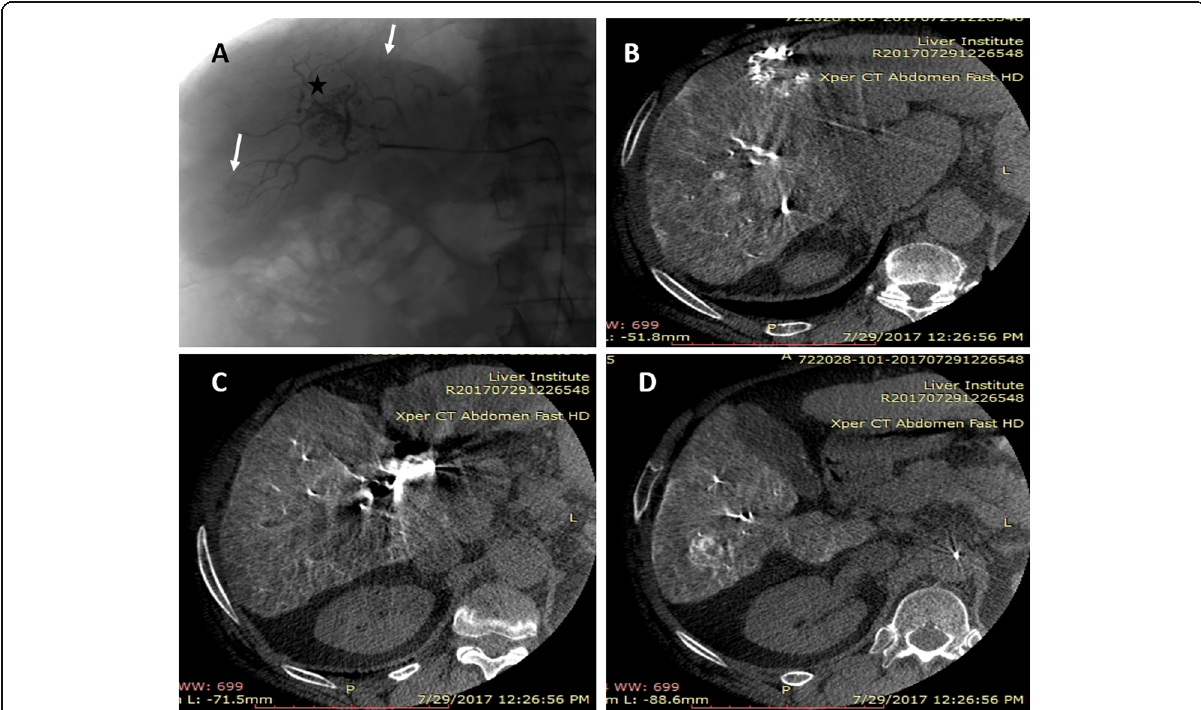
Fig. 3 A 67-year-old male patient coming for a second TACE session for a newly developed HCC focus. a Non-selective angiography of the main right hepatic artery revealing the vascular anatomy of the right hepatic artery up to fifth-order branches as well as the hyper-dense concentrates of the previously managed hepatic focal lesion (asterisk) and de novo two enhanced focal lesions (arrows). No catheter or lipiodol-induced artifacts could be detected. b – d Images of CBCT of the same patient showing mild lipiodol streak artifacts of the previously injected lesion ( b ), moderate catheter-induced artifacts ( c ), and mild motion artifacts ( d ) appearing as double contour of the vessels; d also shows the de novo focal